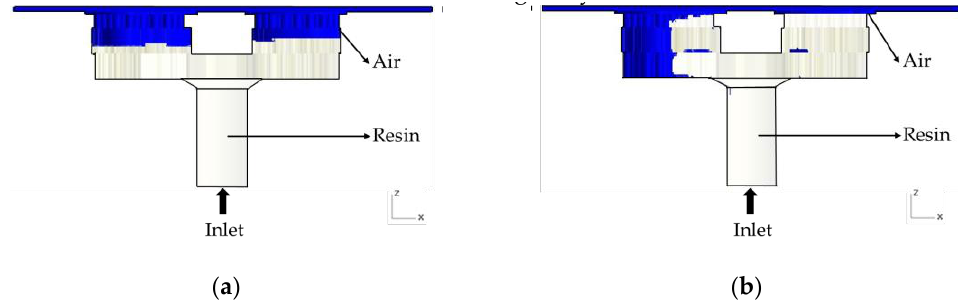
Figure 9. The effect of gravity on simulation ( a ) considering gravity and ( b ) not considering gravity.